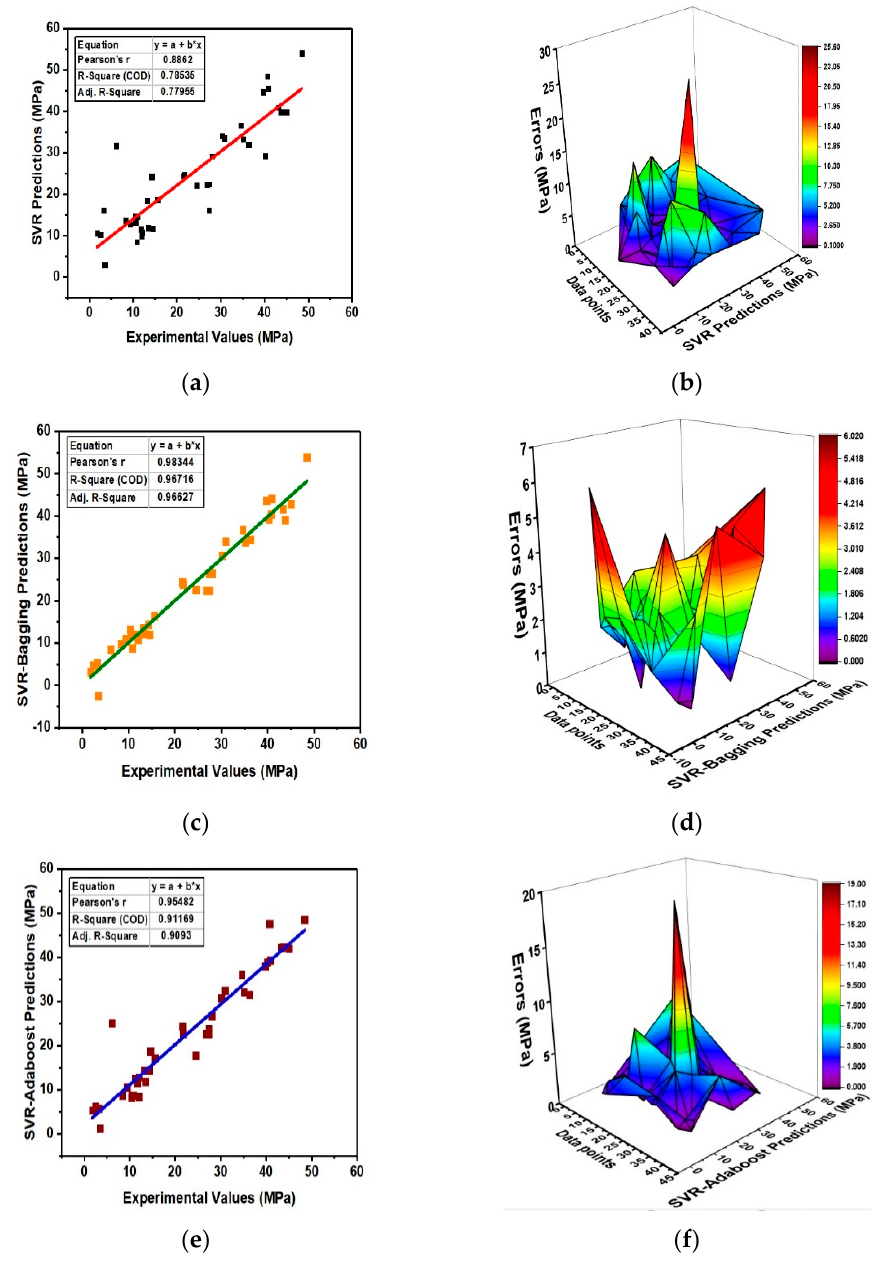
Figure 4. ( a ) SVR relation and ( b ) error distribution; ( c ) SVR-Bagging relation and ( d ) error distribution; ( e ) SVR-Adaboost relation and ( f ) error distribution between experimental and prediction values. Table 5. Statistical evaluation of different ML modeling